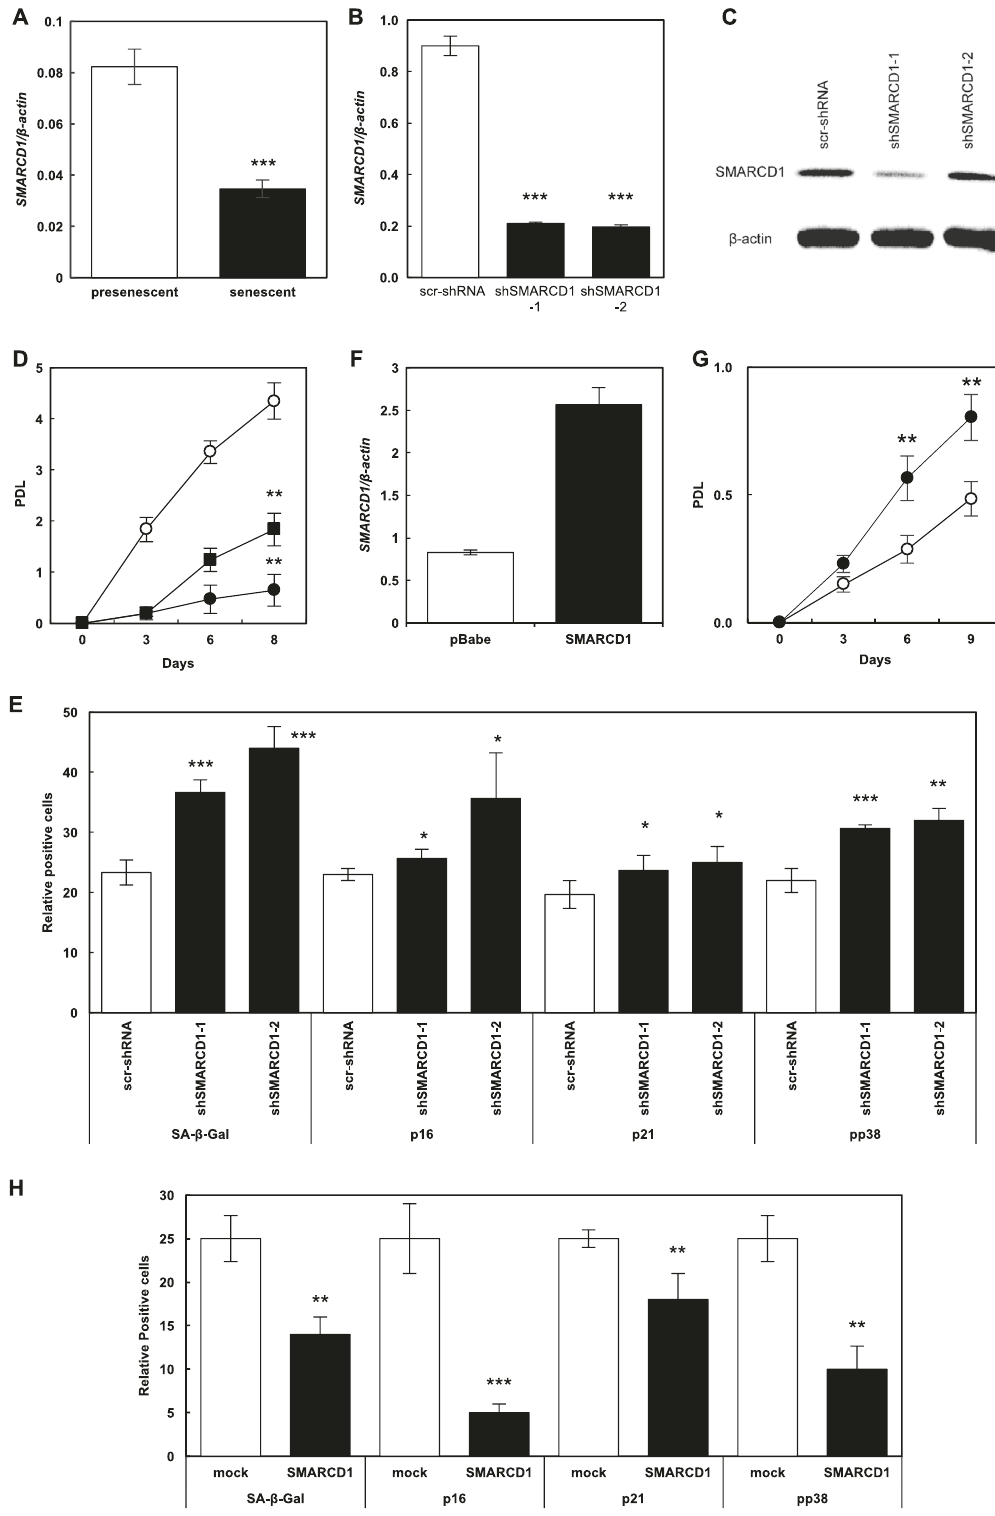
Fig. 1 Functional analysis of SMARCD1 role in cellular senescence. Relative gene expression of SMARCD1 in presenescnet and senescent TIG-1 cells ( a ), in scramble shRNA (scr-shRNA)-transduced and SMARCD1-silenced presenescent TIG-1 cells ( b ), and in mock-transduced and SMARCD1-overexpressing senescent TIG-1 cells (F). ( c ) Expression of SMARCD1 in scr-shRNA-transduced and SMARCD1-silenced presenescent TIG-1 cells. ( d ) Proliferation rate of scr-shRNA-transduced ( ○ ) and SMARCD1 -silenced presenescent TIG-1 ( ● , shSMARCD1-1; ■ , shSMARCD1-2). Cellular senescence phenotypes, quantitatively analyzed by IN Cell analyzer 1000. Activity and expression of senescence markers were measured in scr-shRNA-transduced and SMARCD1 -silenced presenescent TIG-1 cells ( e ), and in mock-transduced and SMARCD1- overexpressing senescent TIG-1 cells ( h ). ( g ) Proliferation rate of mock- ( ○ ) and SMARCD1-transduced TIG-1 cells ( ● ). Data were analyzed by two-sided Student ’ s t -test and expressed as mean ± SD. P < 0.05 was considered signi fi cant ( * P < 0.05; ** P < 0.01; *** P <